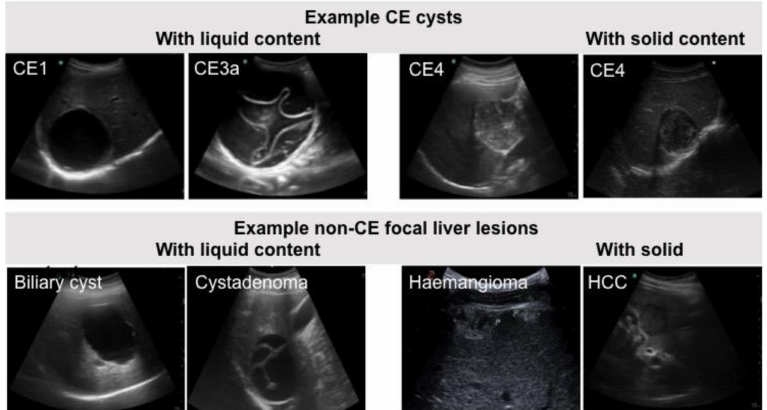
Figure 1. Example ultrasound images of focal liver lesions in differential diagnosis with CE. Top panel: CE cysts in active (CE1) and transitional (CE3a) stages, having a liquid content, and inactive (CE4) stage with solid appearance. Lower panel: focal liver lesions of other etiology with liquid (biliary cyst and cystadenoma) and solid (atypical haemangioma) appearance. HCC: hepatocellular carcinoma.